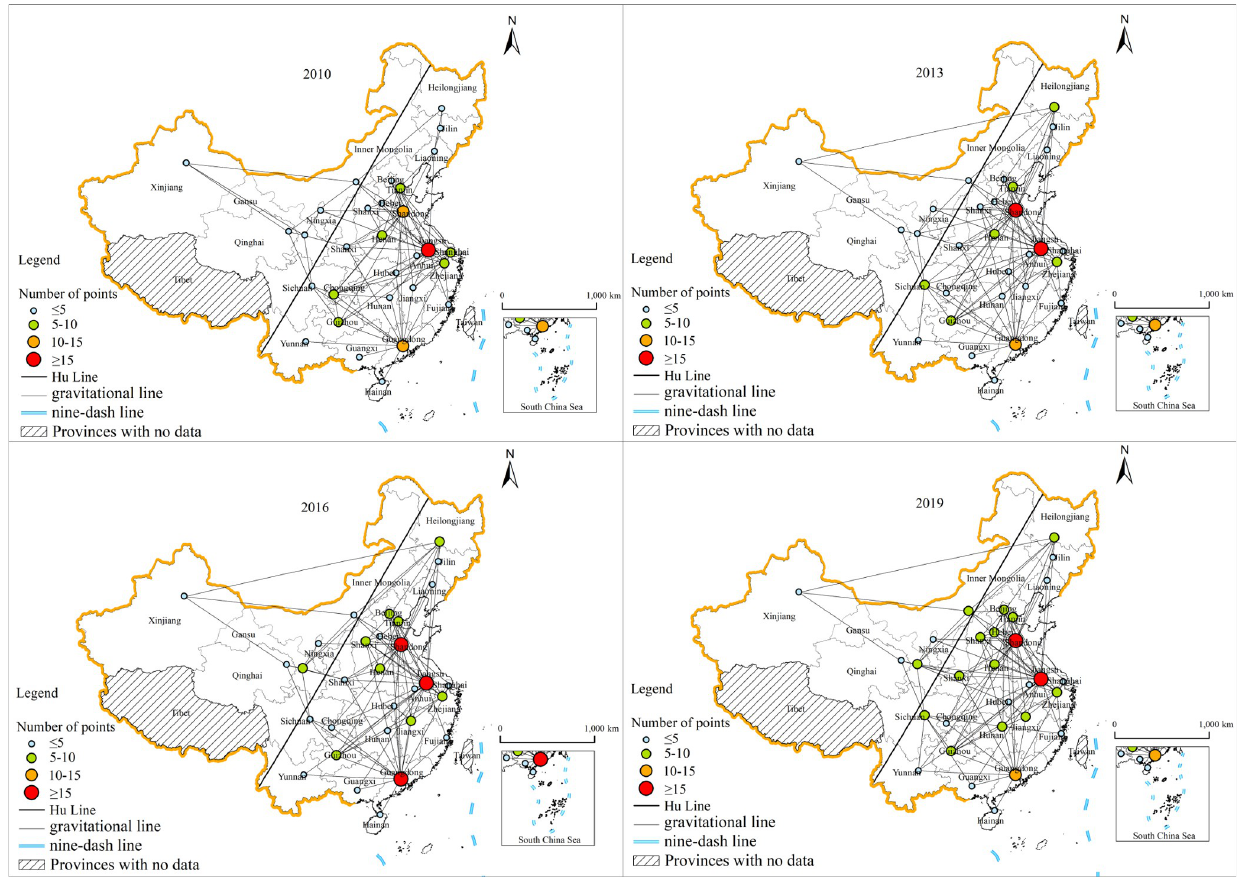
Fig 4. Spatial correlation network of provincial tourism ecological efficiency of China in 2010, 2013, 2016 and 2019. (This map is based on the standard map with review number GS(2019)1697 downloaded from the Ministry of Natural Resources Standard Map Service website (http://bzdt.ch.mnr. gov.cn), and the base map has not been modified).